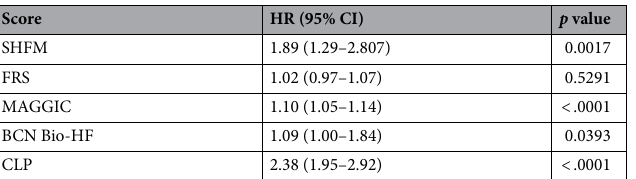
Table 2. Prognostic scores and univariate hazard ratios for cardiovascular mortality. Unadjusted Cox proportional hazard models of 10-year outcome for cardiovascular mortality. Total subjects, n = 280. Total events, n = 95. SHFM (Seattle Heart Failure Model), FRS (Framingham Risk Score), and MAGGIC (Meta- analysis Global Group in Chronic Heart Failure), BCN Bio-HF (Barcelona Bio-Heart Failure Risk Calculator), and Cardiac Lipid Panel Risk Score